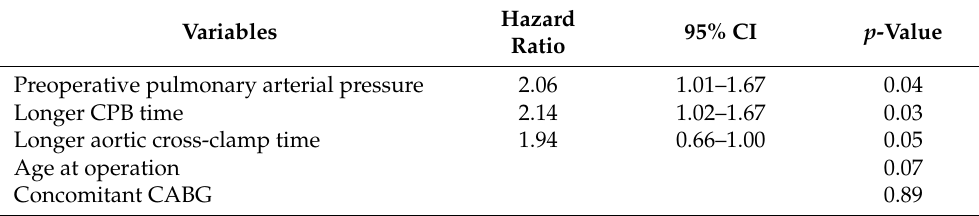
Table 1. Independent predictors for hospital mortality and low cardiac output